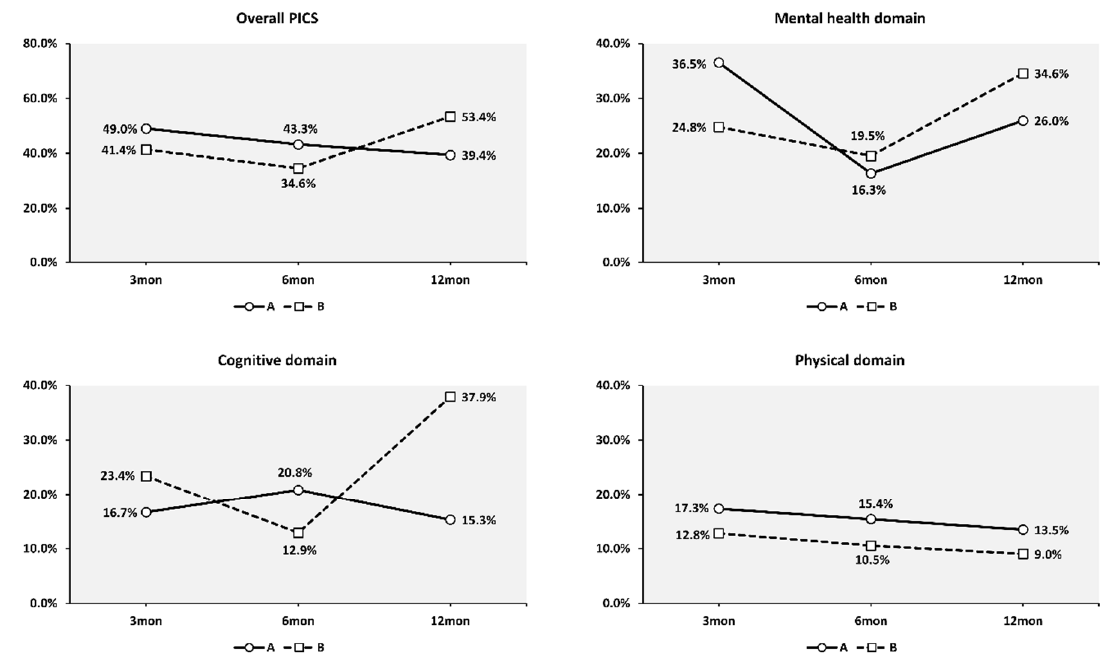
Figure 3. Post-intensive care syndrome prevalence in Groups A and